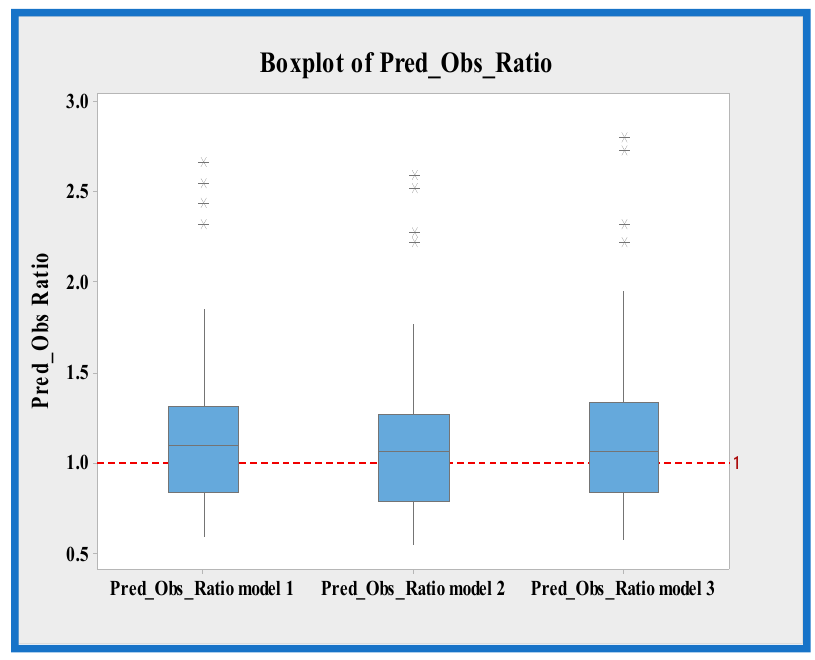
Figure 5. Boxplot comparing the ratio of predicted and observed productivity values of Models 1, 2, and 3 (con-still). (Here the * sign represents outlier data points).